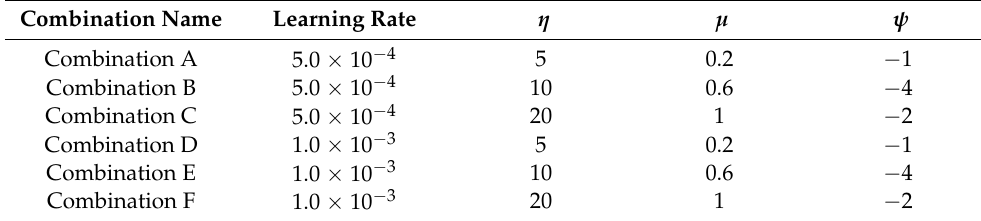
Table 4. Different parameter combinations for